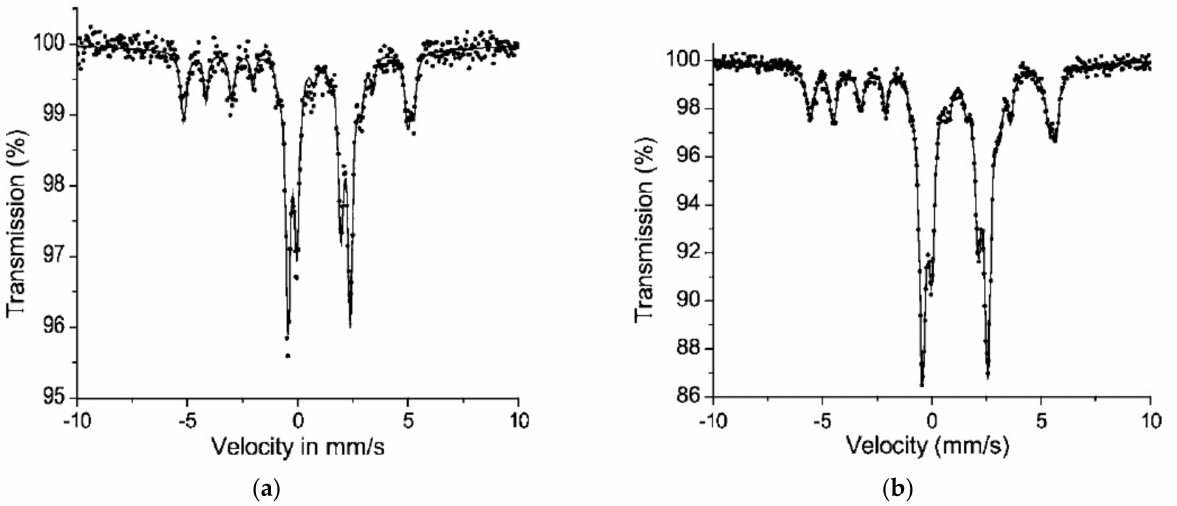
Figure 13. Room temperature Mössbauer spectra of equilibrated ordinary chondrites Gujargaon H5 ( a ) and Didwana H5 ( b ). Adapted from Reference [62].